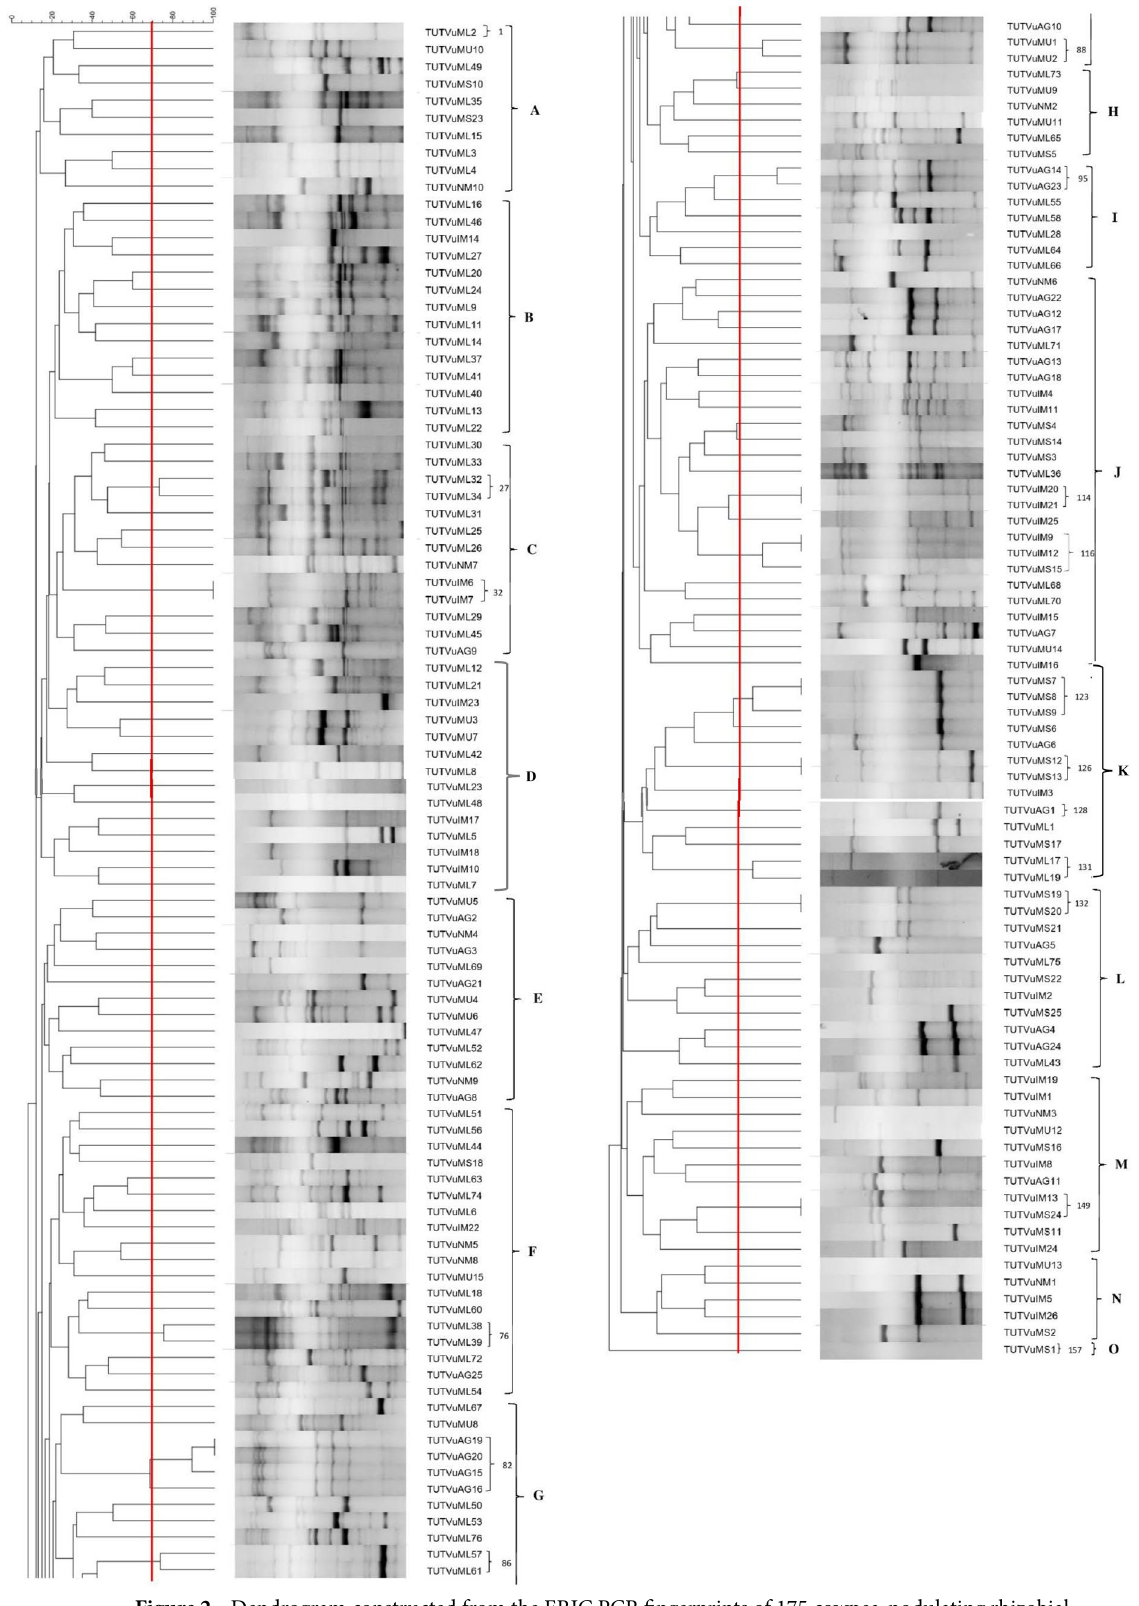
Figure 2. Dendrogram constructed from the ERIC PCR fingerprints of 175 cowpea-nodulating rhizobial isolates from two agroecological zones of Mozambique. Major clusters are labelled with Bold alphabets. The cowpea isolates having distinct ERIC PCR profiles at a cut-off point of 70% similarity (indicated by red line) are labelled using Arabic numerals. Where consecutive isolates possess different ERIC PCR profiles, the numbering is skipped and continued at the next group of